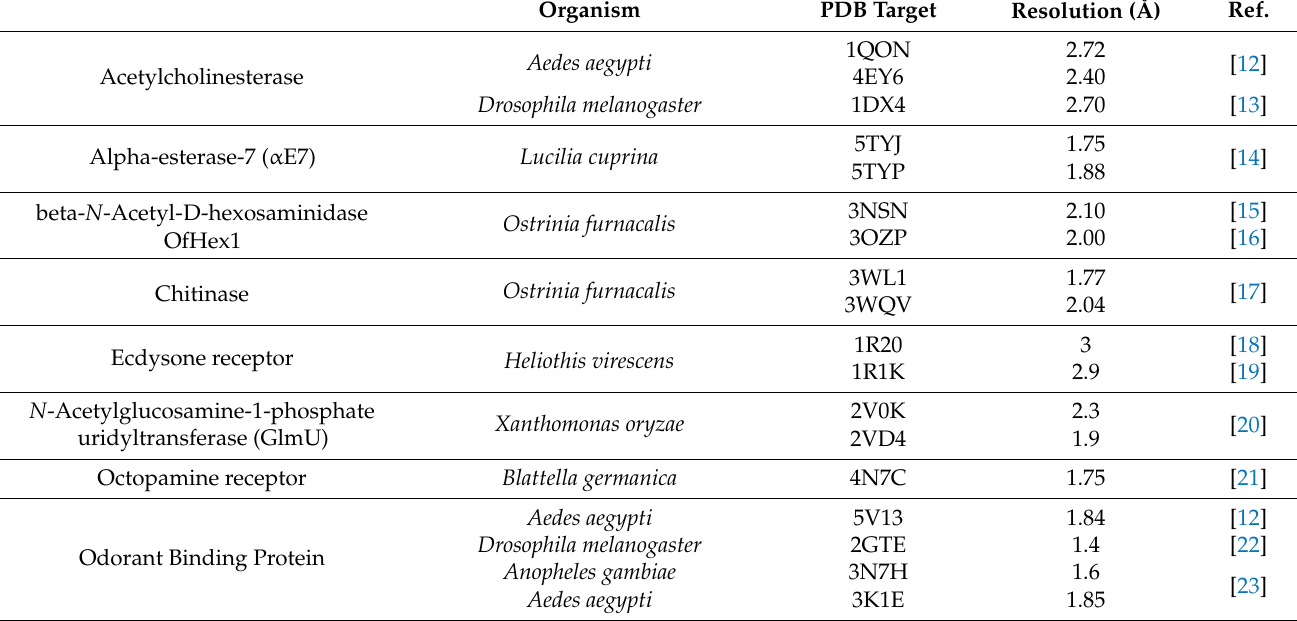
Table 1. List of targets selected for the Inverted Virtual Screening